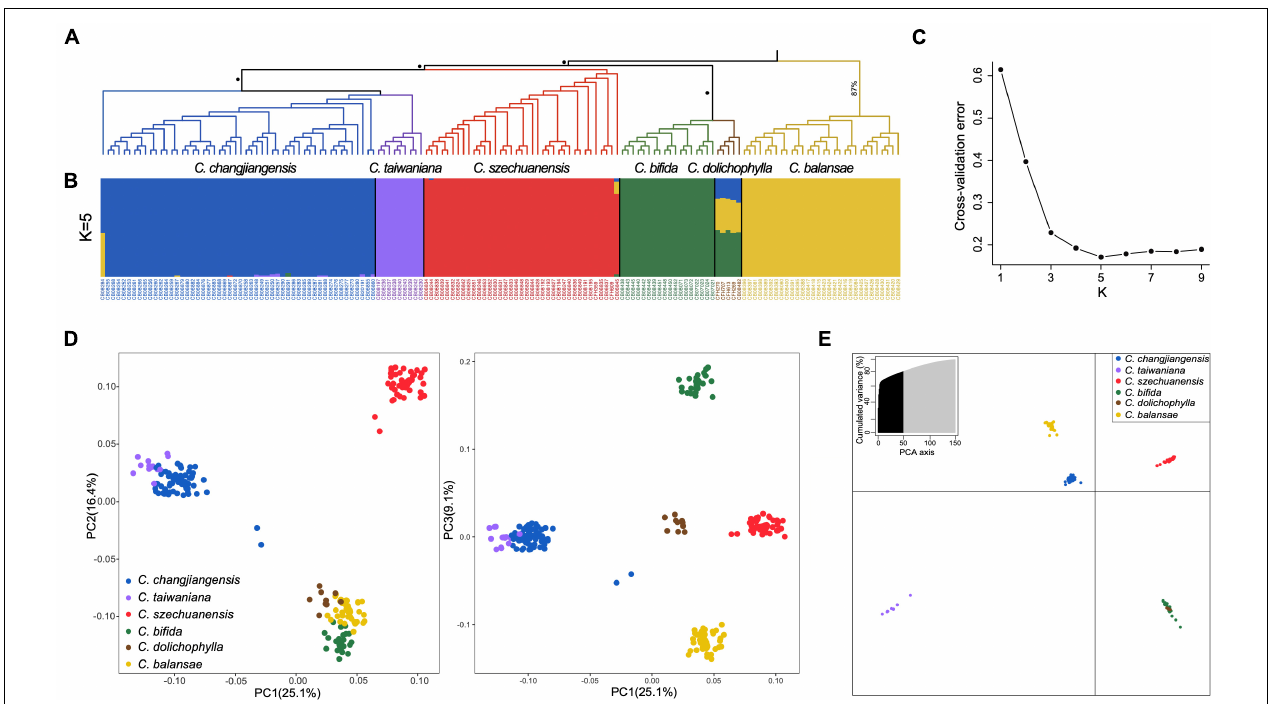
FIGURE 3 | Phylogenetic relationship and estimated genetic structure for the six Cycas species. (A) Phylogenetic tree of the six Cycas species generated using I Q -Tree (Node with 100% bootstrap support is marked with a black dot); (B) Results from A DMIXTURE with K = 5 based on genome-wide SNP data; (C) Cross-validation plot for K = 1–9 obtained with A DMIXTURE ; (D) Plots of the first three dimensions of principal component analysis for the six Cycas species, with the first three axes (PC1, PC2, and PC3) explaining 25.1, 16.4, and 9.1% of the variation, respectively; (E) Plot of the first two dimensions of discriminant analysis of principal component (DAPC), with the first two axes (PC1 and PC2) explaining 33.4 and 18.4% of the variation, respectively.